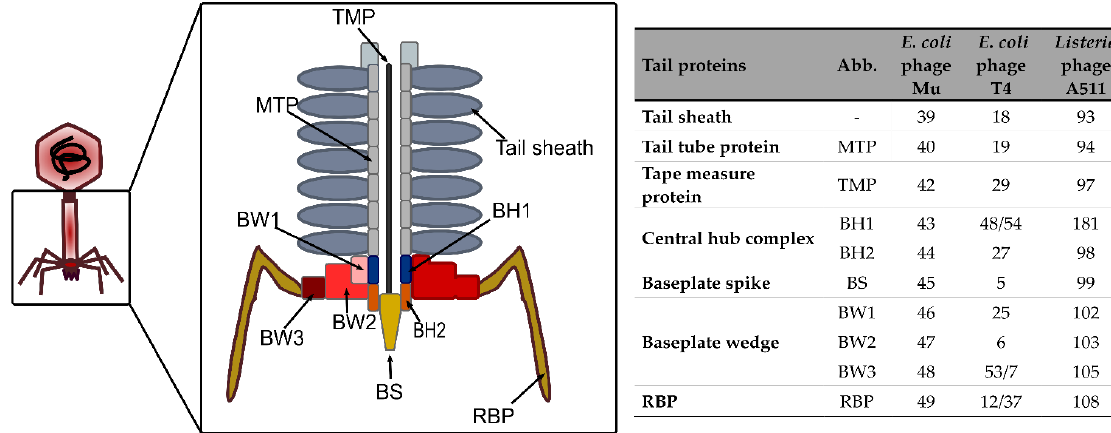
Figure 3. Schematic representation of a myovirus contractile tail . The tail of myoviruses infecting both Gram-positive and Gram-negative hosts harbor conserved proteins that are represented in this scheme. The complete baseplate wedge structure (formed by three types of proteins) is highlighted in red on the right side of the scheme. The table on the right gives the gene product correspondences for each baseplate protein between the two reference phages infecting E. coli (T4 and Mu) and the L. monocytogenes phage A511. TMP: Tape Measure Protein; BW: Baseplate Wedge protein; BH: Baseplate Hub protein; BS: Baseplate Spike; RBP: Receptor Binding Protein; TF: Tail Fiber; MTP: Major Tail Protein.